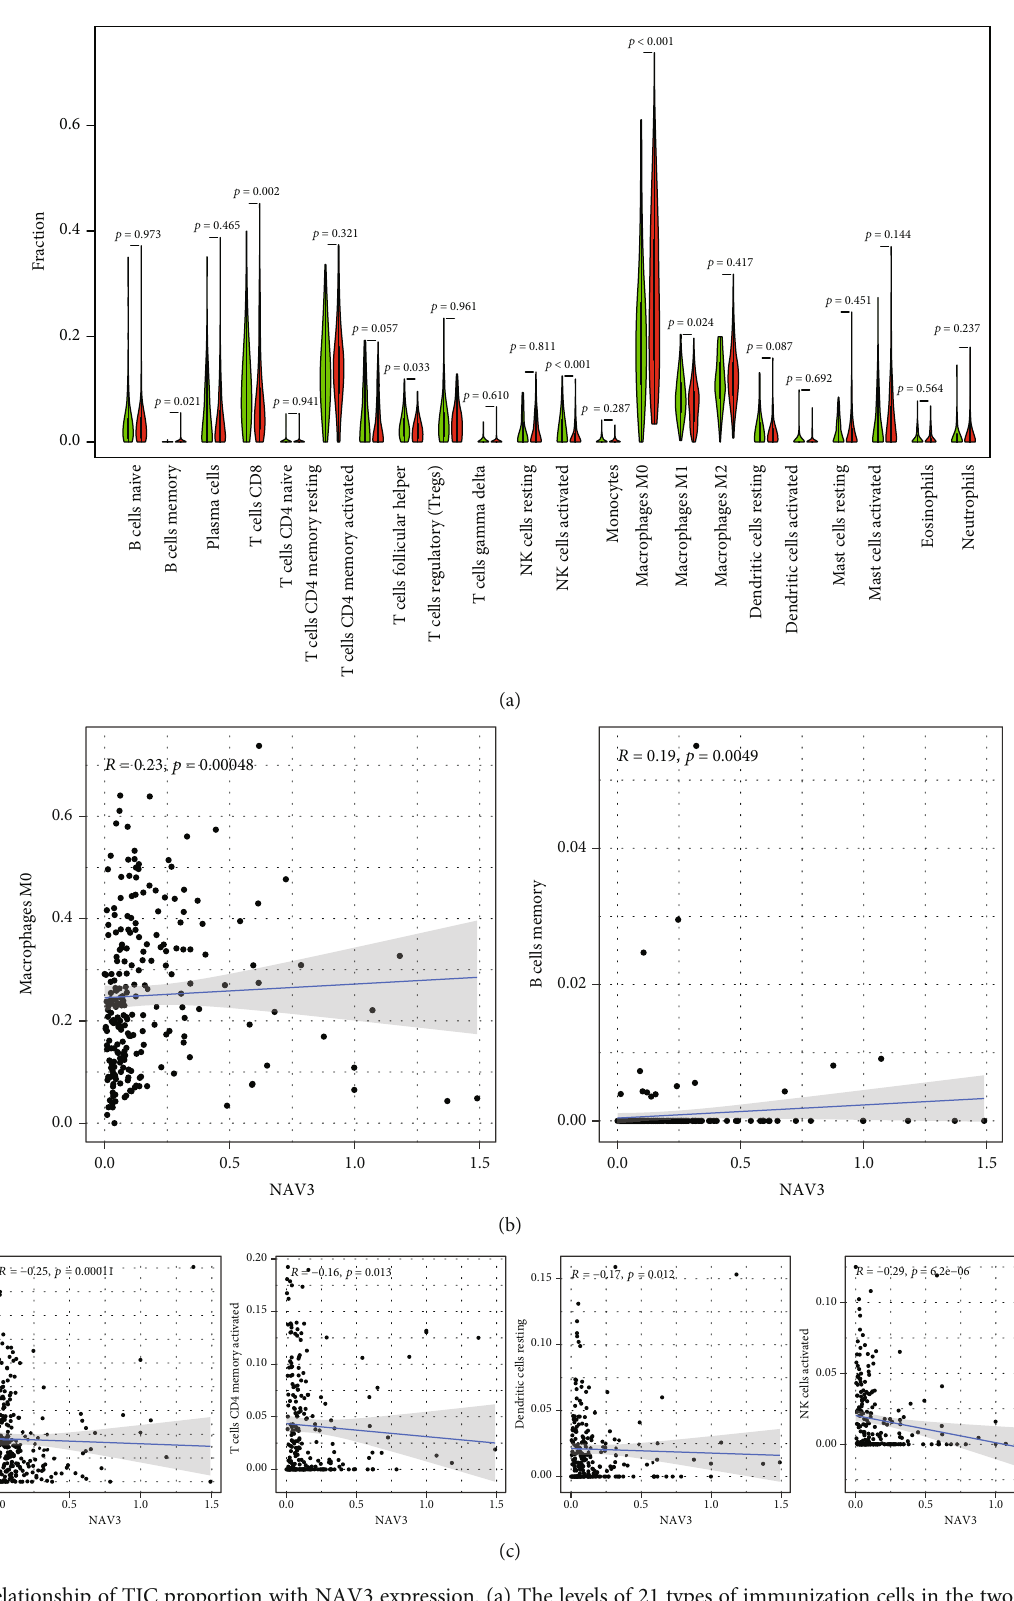
Figure 8: Relationship of TIC proportion with NAV3 expression. (a) The levels of 21 types of immunization cells in the two groups (high and low). (b, c) The relationship investigation between the levels of 21 types of immunization cells and the levels of NAV3 in